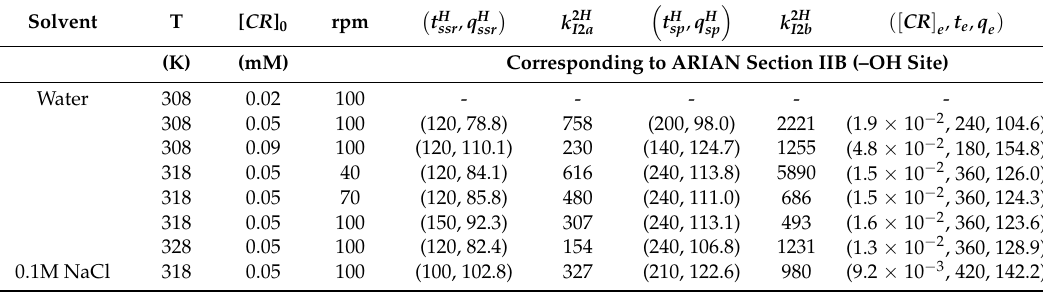
Table 10. Coefficients of region 2 (part 2a and 2b) of the ISO equation for kinetics of CR adsorption on the hydroxyl or –NH 2 sites of GO/PAMAM (on the second kinetic curve) at 308–328 K. Solvent T